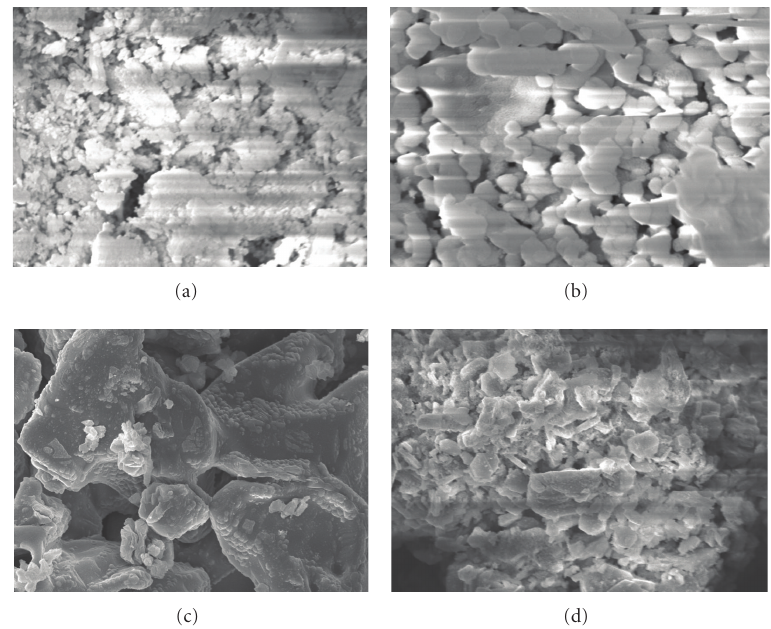
Figure 2: SEM pictures of Buccinum tenussimum shell biomass before adsorption of metals. (a) ground original sample, (b) heat-treatment (480 ◦ C) sample, (c) heat-treatment (950 ◦ C) sample, and (d) heat-treatment (950 ◦ C) and water-added